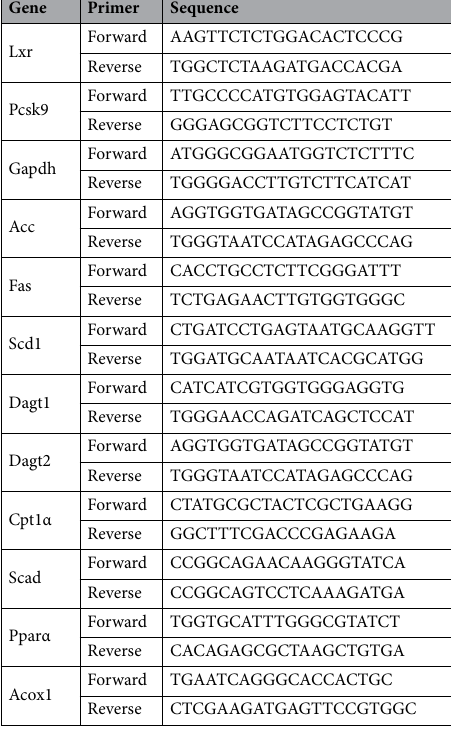
Table 1. Oligonucleotide sequences of primers targeting mouse genes.